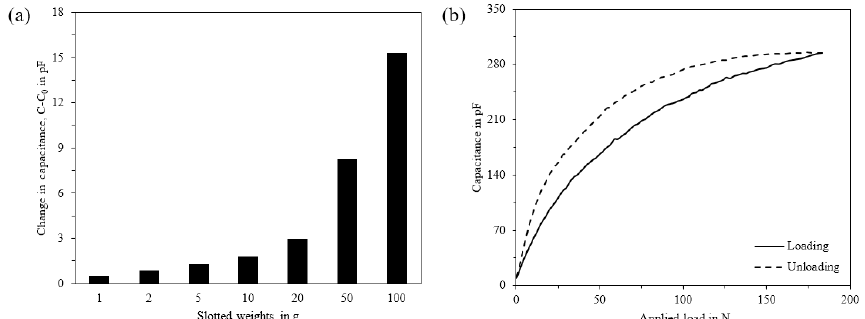
Figure 5. (a) Change in capacitance ( C − C 0 ) of the sensor under load from slotted weights in the range 1–100g, and (b) capacitance response of the pressure sensor for loading and unloading to a maximum load of 180N.